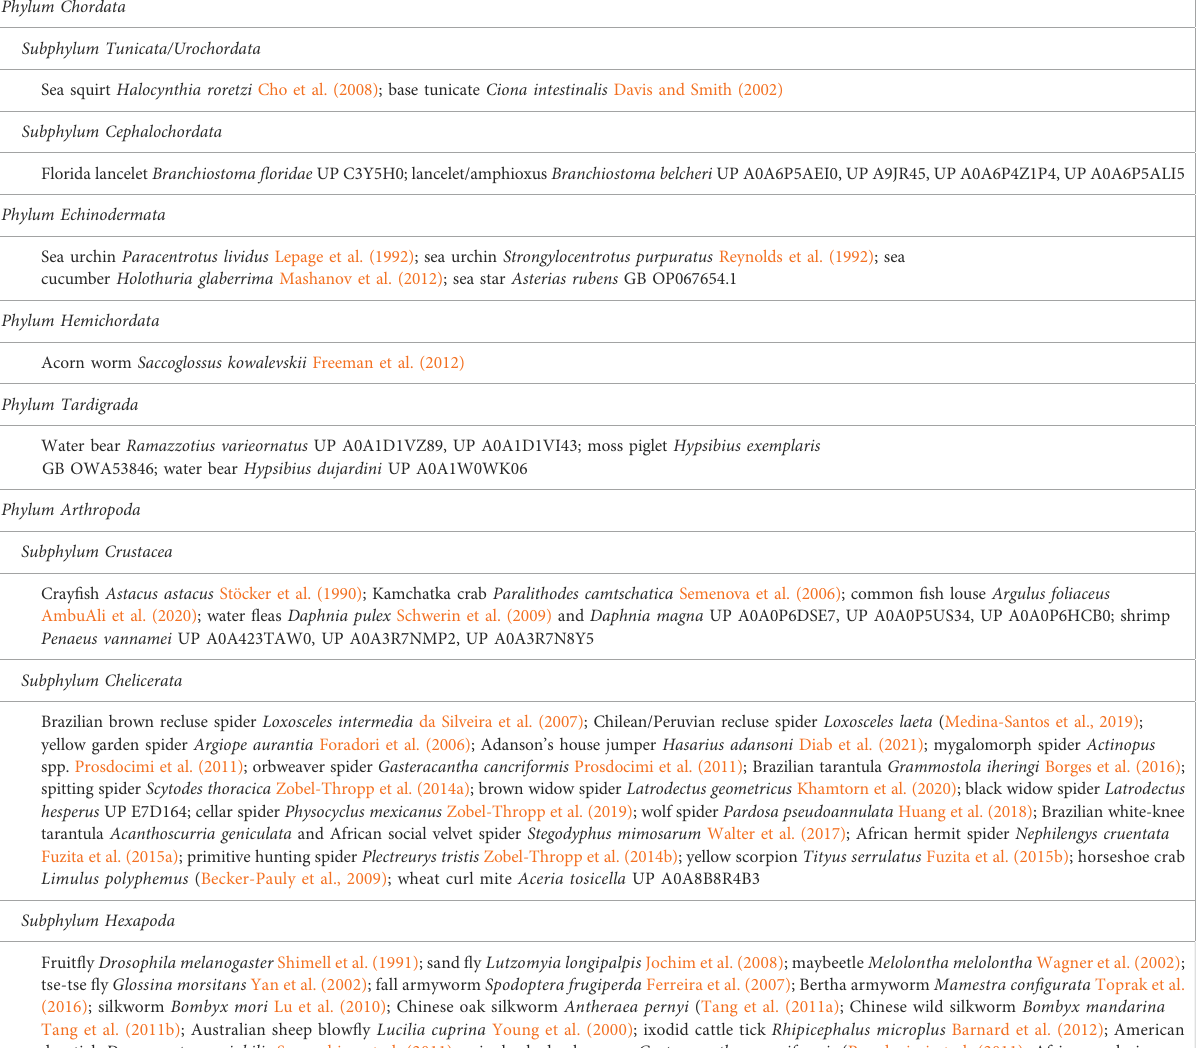
TABLE 1 Representative sequences of studied and potential non-vertebrate metazoan astacins. Phylum